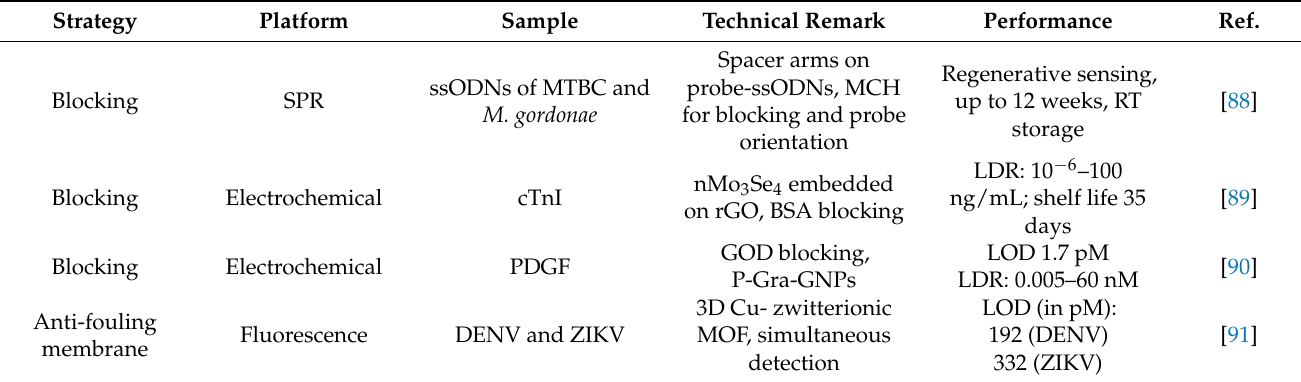
Table 3. Summary of the specificity enhancement.